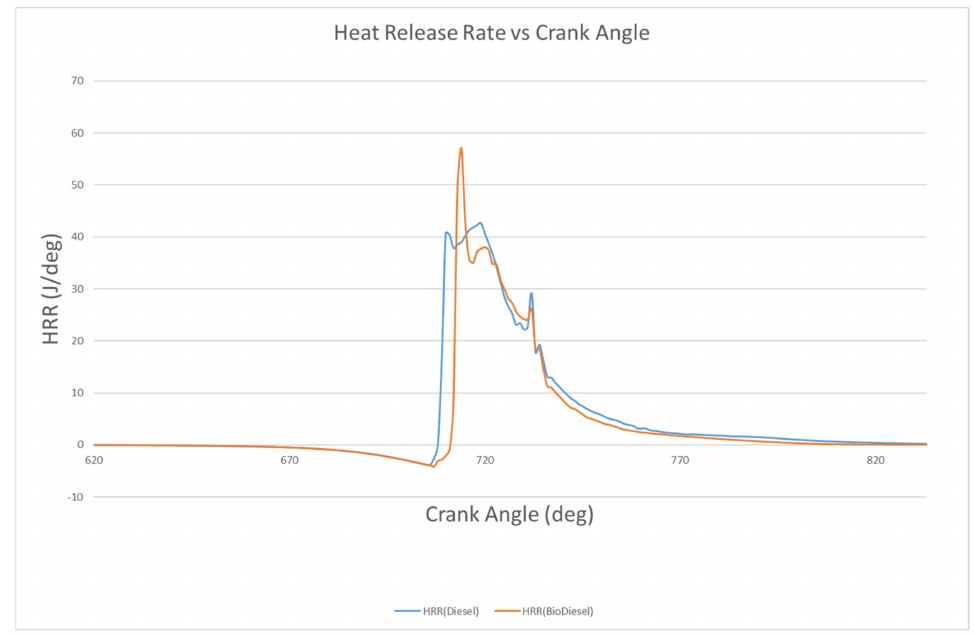
Figure 14. Heat release rate vs. crank